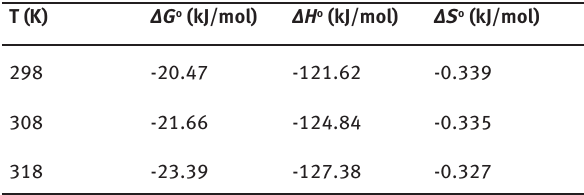
Table 5: Kinetic constants of Film and Particle diffusion models.